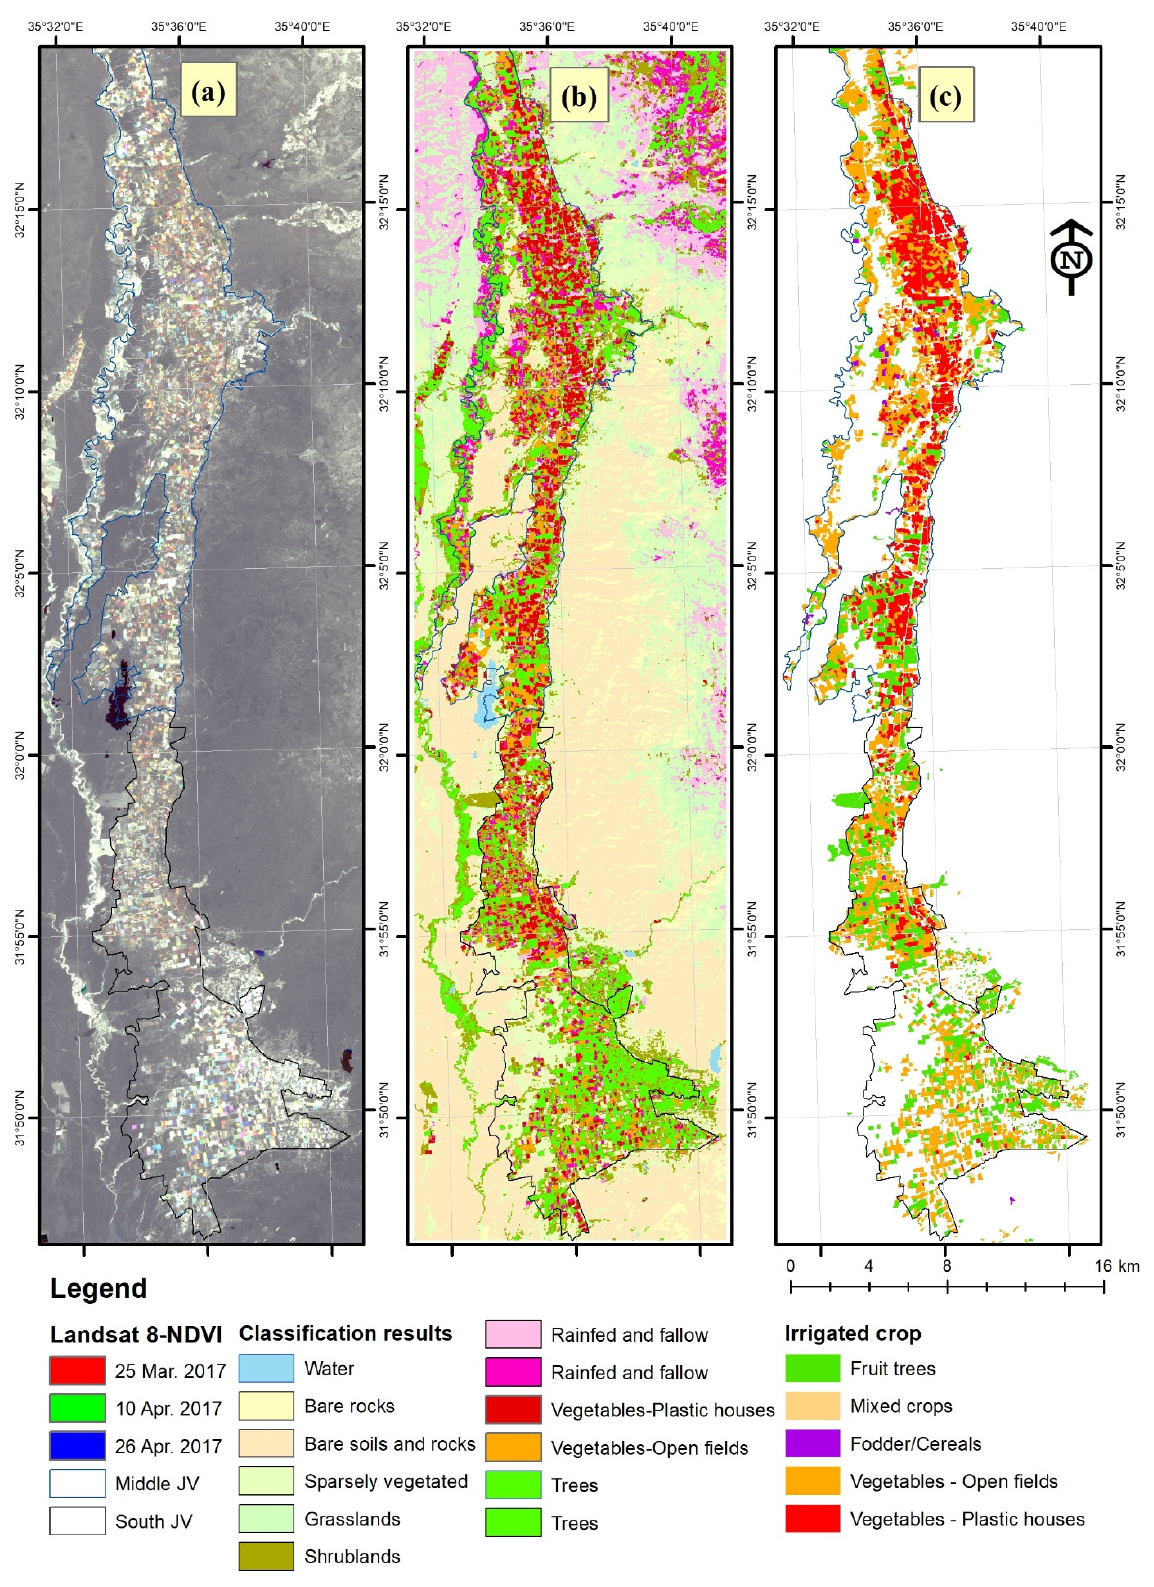
Figure 4. Mapping of irrigated crops in MSJV. ( a ) Multi-temporal NDVI layers covering the whole year; ( b ) Results of the unsupervised classification of the NDVI images; ( c ) Final map of irrigated crops after editing, merging of ground data, and applying different GIS overlay functions.